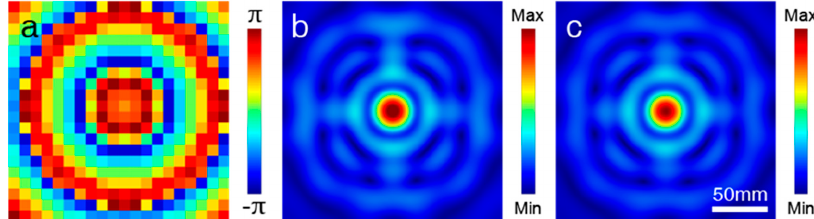
Figure 4. Acoustic field distributions in the single-focal scenario. ( a ) Calculated discrete phase distribution of the acoustic field on the hologram plane. ( b ) Simulated amplitude distribution of the reflected acoustic field on the hologram plane without considering thermoviscous effects. ( c ) Simulated amplitude distribution of the reflected acoustic field on the hologram plane considering thermoviscous effects. The simulation settings were kept consistent with the calculated